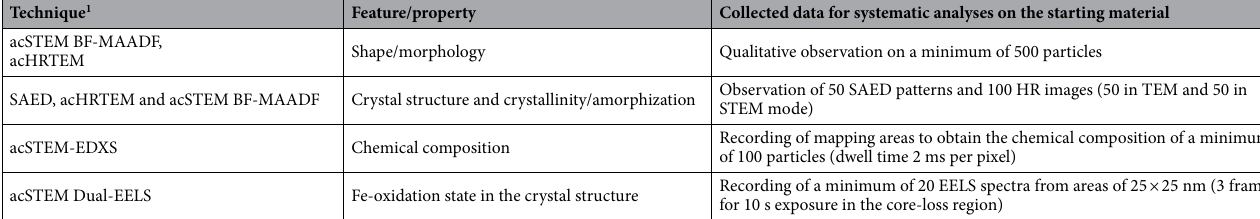
Table 1. Summary of the S/TEM techniques used for the characterization of both the starting and the interacted material. 1 Additional Abbreviations: acSTEM = aberration corrected Scanning Transmission Electron Microscopy; BF = Bright Field; MAADF = Medium-Angle Annular Dark Field; SAED = Selected Area Electron Diffraction; HR = High-Resolution; EDXS = Energy-Dispersive X-Ray Spectroscopy; EELS = Electron Energy-Loss